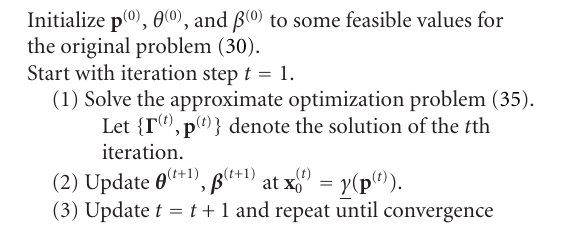
Algorithm 1: Series of convex